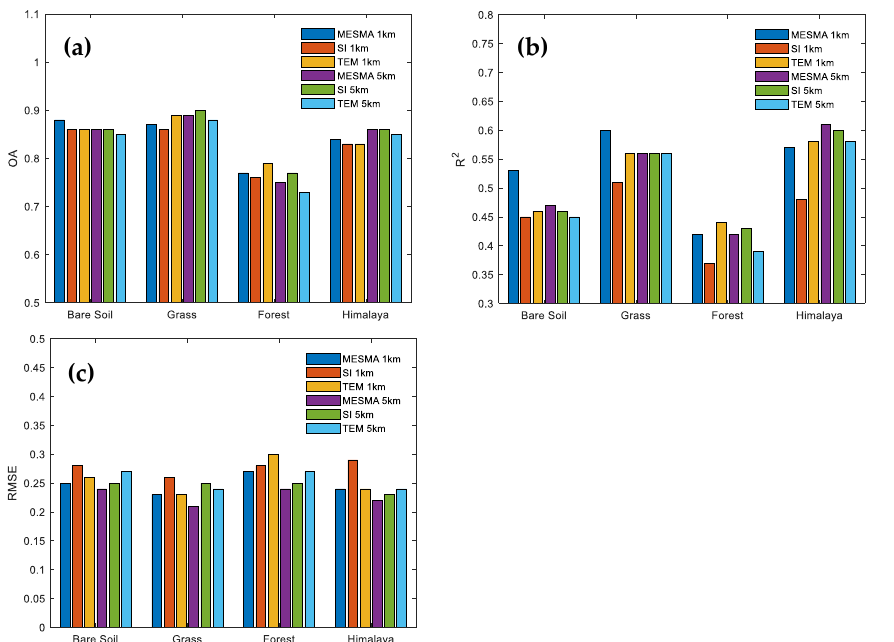
Figure 6. Accuracy evaluation results under different surface types for three AVHRR/2 fractional- snow-cover retrieval algorithms at 1 km and 5 km scales based on 313 Landsat-5/TM scenes: ( a ) the OA of the three AVHRR/2 FSC retrieval algorithms at 1 km and 5 km scales; ( b ) the R 2 of the three AVHRR/2 FSC retrieval algorithms at 1 km and 5 km scales; ( c ) the OA of the three AVHRR/2 FSC retrieval algorithms at 1 km and 5 km scales.